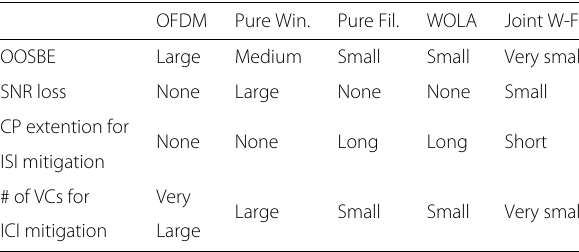
Table 3 Comparison of the waveforms OFDM Pure Win. Pure